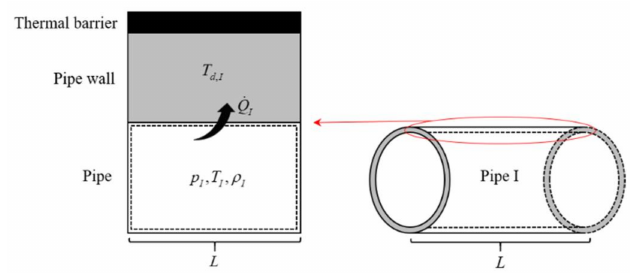
Figure 2. Schematic diagram of heat transfer process.